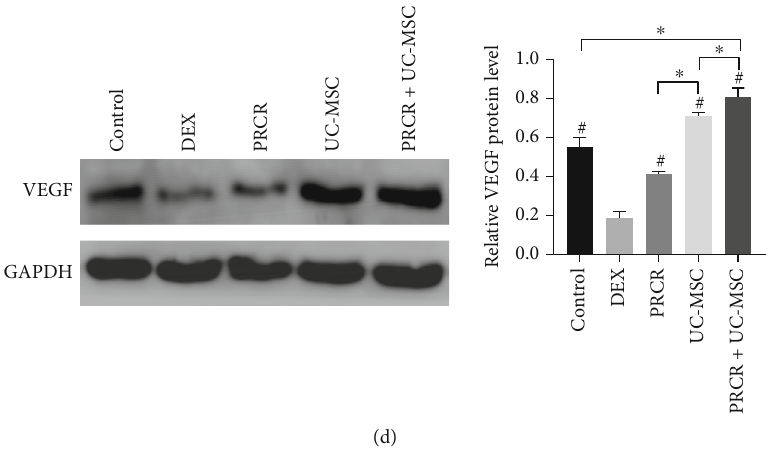
Figure 3: In vitro e ff ects of PRCR, UC-MSCs, and PRCR + UC-MSCs on the proliferation, migration, and capillary-like tube formation of DEX-treated HUVECs in the coculture systems (a) Cocultured with PRCR, UC-MSCs, and PRCR + UC-MSCs, the cell viability of DEX- treated HUVECs was examined by CCK-8 assay. These three treatment groups showed signi fi cant promotion of the HUVEC proliferation inhibited by DEX ( P < 0 : 05 ). (b) Migration activities of DEX-treated HUVECs were examined by Transwell assay in di ff erent coculture conditions, followed by quantitative analysis. The treatment groups showed signi fi cant promotion of the HUVEC migration inhibited by DEX ( P < 0 : 05 ). (c) Representative images of capillary-like tube formation in di ff erent coculture conditions, followed by quantitative analysis. The treatment groups showed signi fi cant promotion of the HUVEC angiogenesis di ff erentiation inhibited by DEX ( P < 0 : 05 ). (d) Western blotting was conducted to evaluate the VEGFA expression. Higher levels of VEGFA protein were detected in all treatment groups compared to the DEX group ( P < 0 : 05 ) ( n = 5 , # Comparisons between the DEX group and other groups, P < 0 : 05 ; ∗ Comparisons between the two groups, P < 0 : 05 ). CCK-8: cell counting kit-8 assay; VEGF: vascular endothelial growth factor; GADPH: glyceraldehyde-3-phosphate dehydrogenase; PRCR: platelet-rich plasma clot releasate; UC-MSCs: umbilical cord mesenchymal stem cells; DEX: dexamethasone